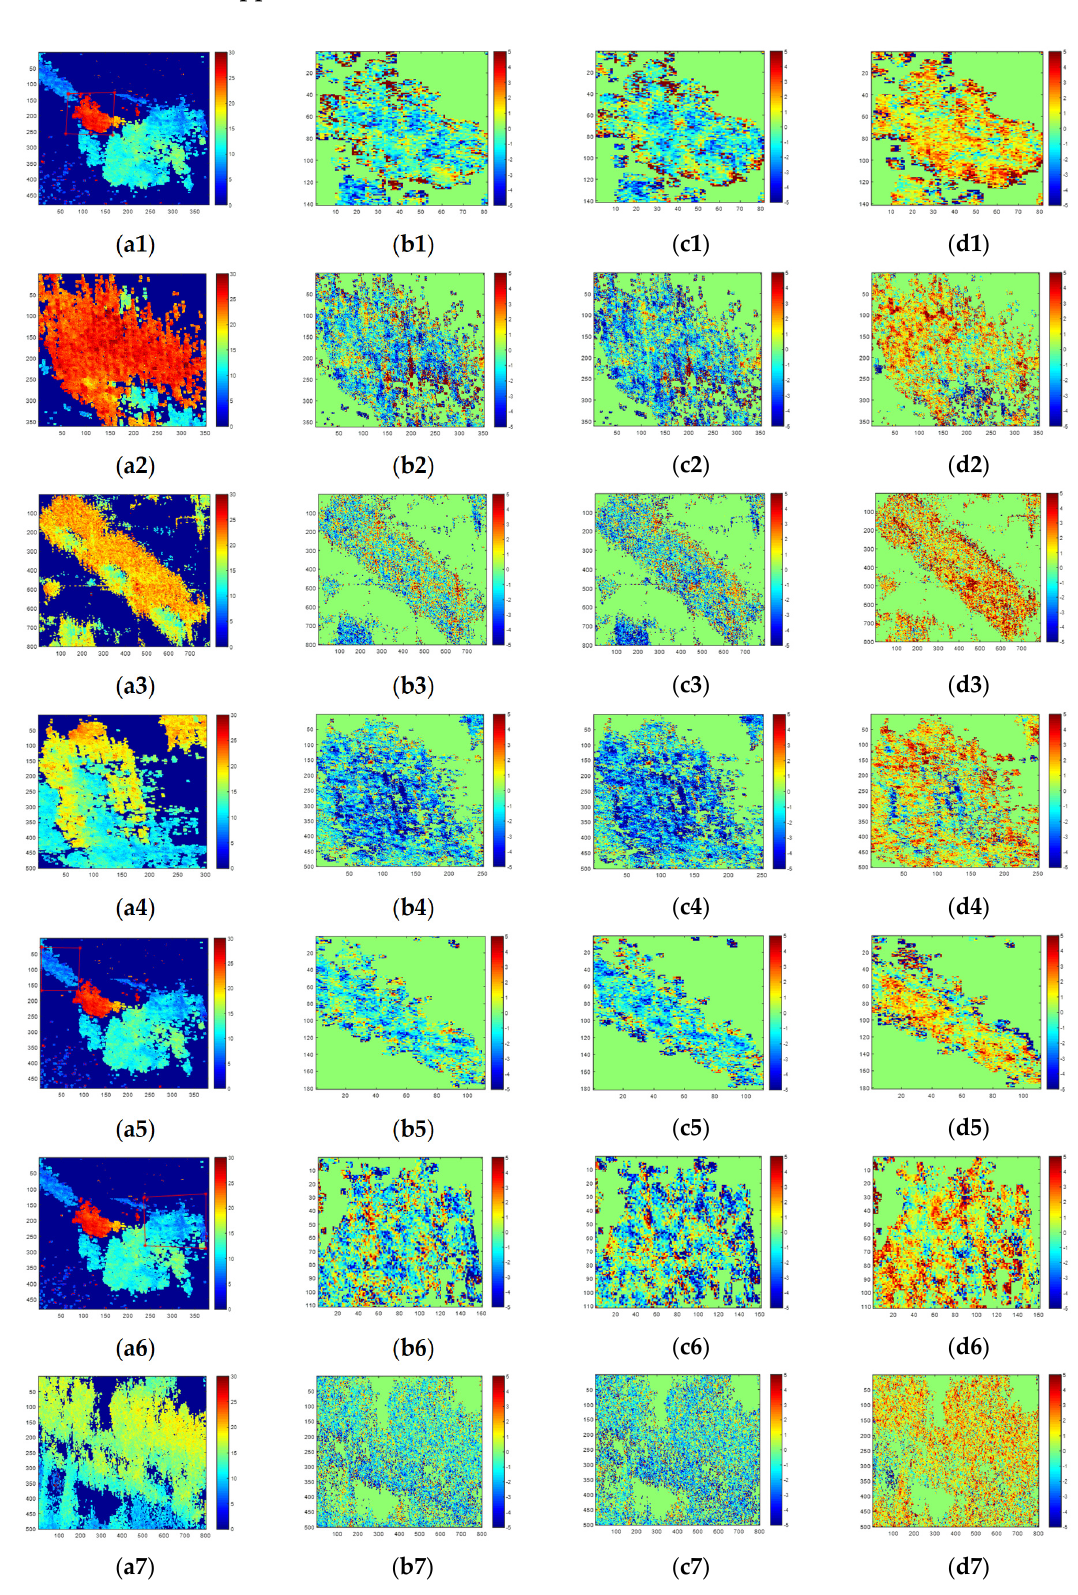
Figure A1. Height difference among PolInSAR and Pauli decomposition of UAV-borne system. ( a1 – a7 ) Height retrieved by PolInSAR. ( b1 – b7 ) Height differnece of PolInSAR optimal decomposition